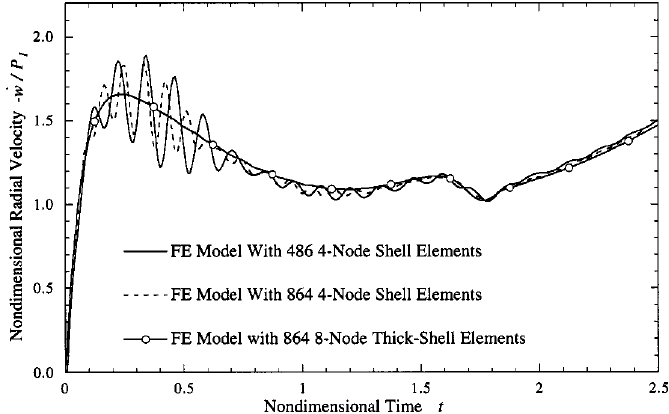
Fig. 13. Shell radial-velocity histories at (cid:18) = (cid:25) for an empty spherical shell excited by a plane step wave ( D = 1 , (cid:12) = 0).